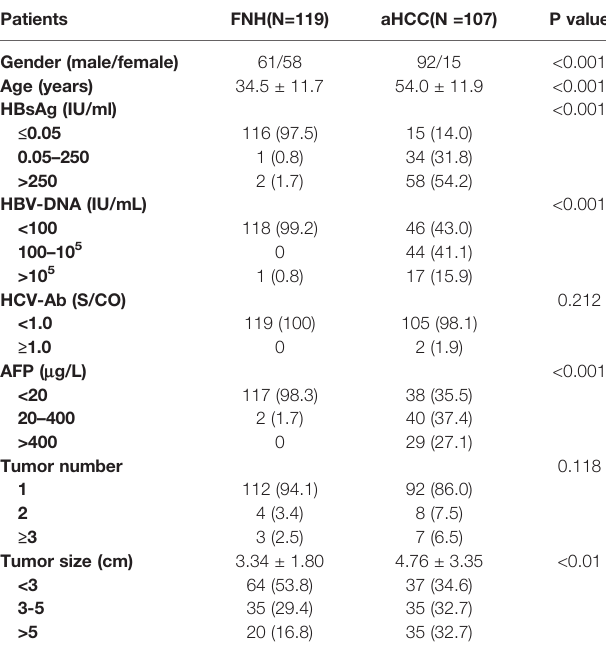
TABLE 1 | Clinical Characteristics and Laboratory Information of the Patients. Patients